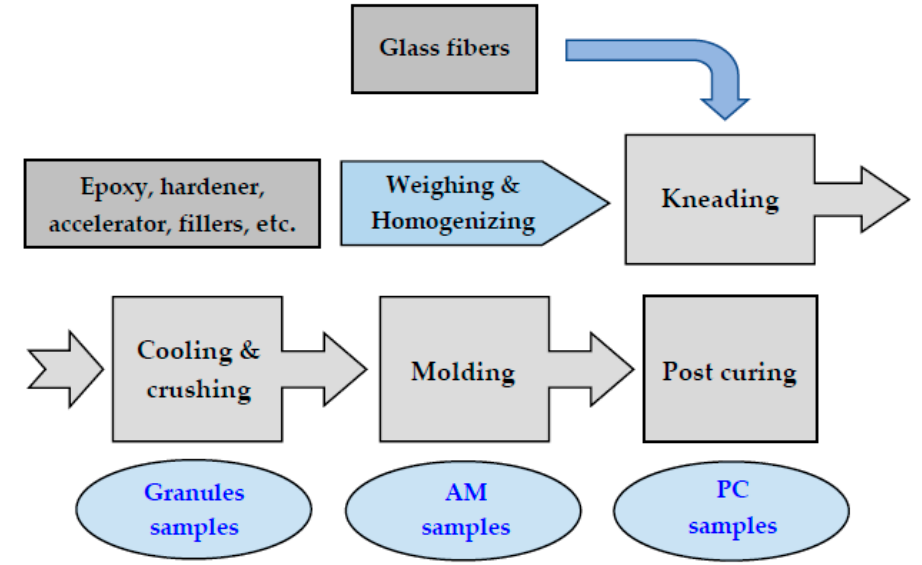
Figure 2. Stages for the preparation of epoxy molding compound.